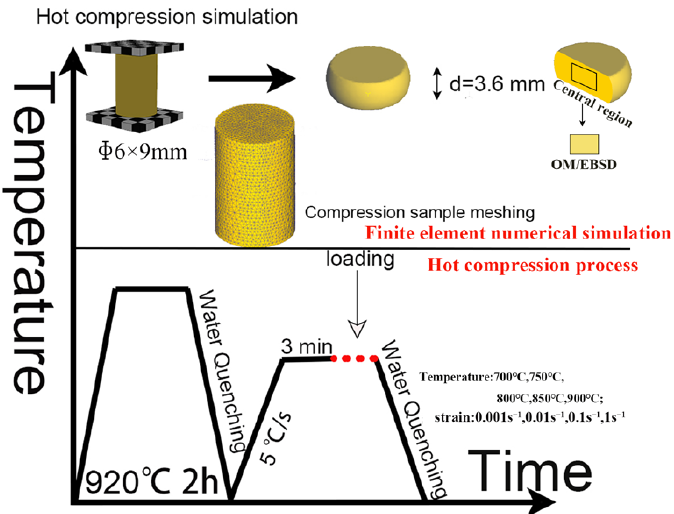
Figure 2. Schematic diagram of the technological process of the whole experiment.